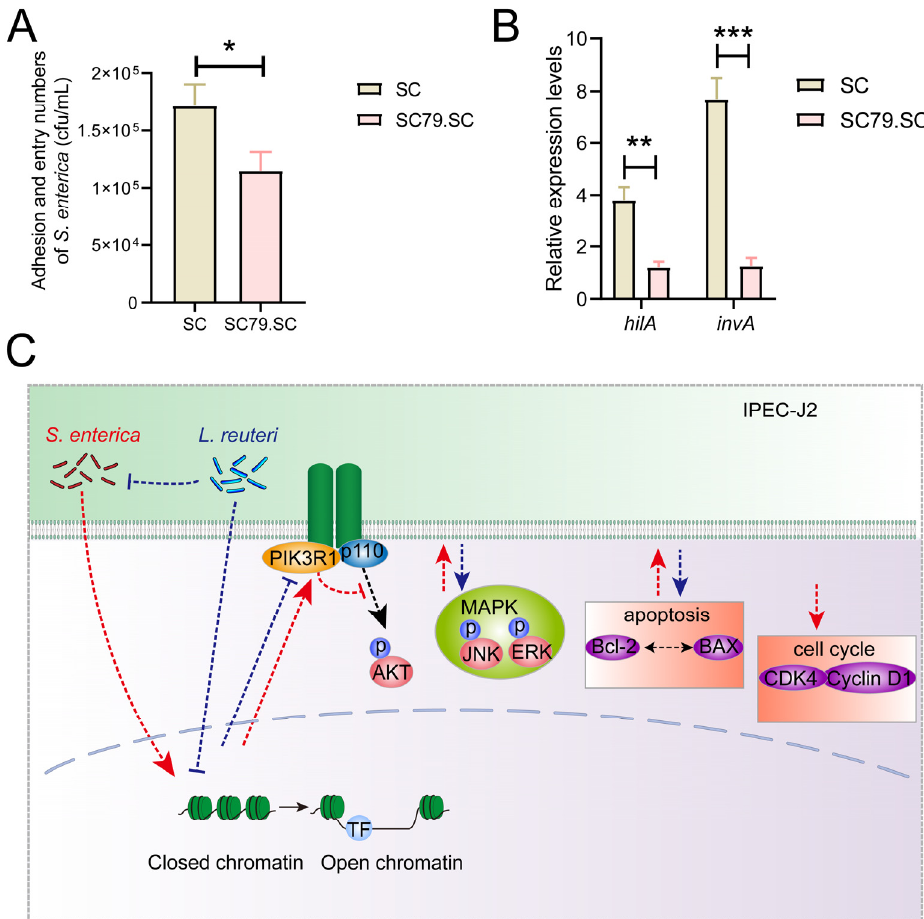
Figure 7. Activation of PI3K/AKT pathway in IPEC-J2 cells inhibits S. enterica BNCC186354 infection. (A , B ) IPEC-J2 cells were pretreated with 4 µg/mL of the AKT activator SC79 for 0.5 h. Adhesion and entry numbers of S. enterica BNCC186354 ( A ) and expression of hilA and invA were detected ( B ). ( C ) Mechanistic hypothesis diagram for the changes in PI3K/AKT, MAPK pathways, cell cycle, and apoptosis in IPEC-J2 cells treated with S. enterica BNCC186354 and L. reuteri ATCC 53608. Red dashed lines represent the effect of S. enterica BNCC186354; blue dashed lines and crosses represent the effect of L. reuteri ATCC 53608. *, p <0.05; **, p <0.01; ***, p <0.001. SC79.SC: SC79 and S. enterica BNCC186354 treatment group.